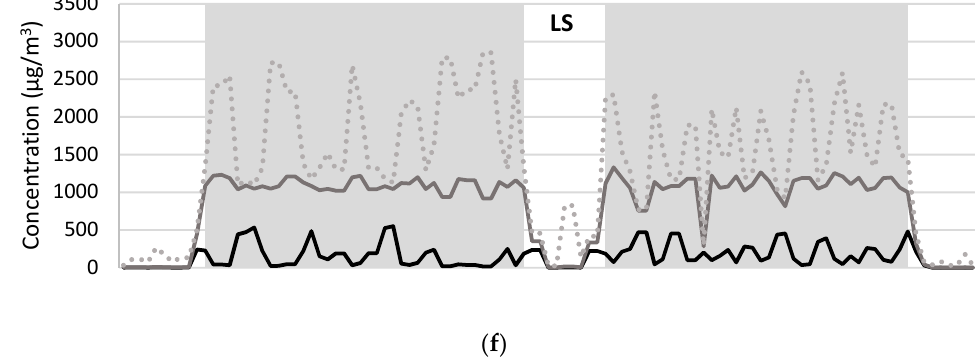
Figure 3. Particulate matter (PM 1.0 , PM 2.5 and PM 10 ) concentrations measured during field trials. The x axes reflect time, with shading indicating the 1 h window of each smoke treatment: ( a – d ) show PM data recorded during the high density smoke exposure (HS) treatments, with sensors positioned amongst the control vines and within the smoke tent, respectively (sensor positions were swapped between the two duplicate HS treatments); ( e , f ) show PM data recorded during the duplicate high smoke with misting (HSM) and low smoke (LS) treatments, respectively (with sensors again positioned within the smoke tent).